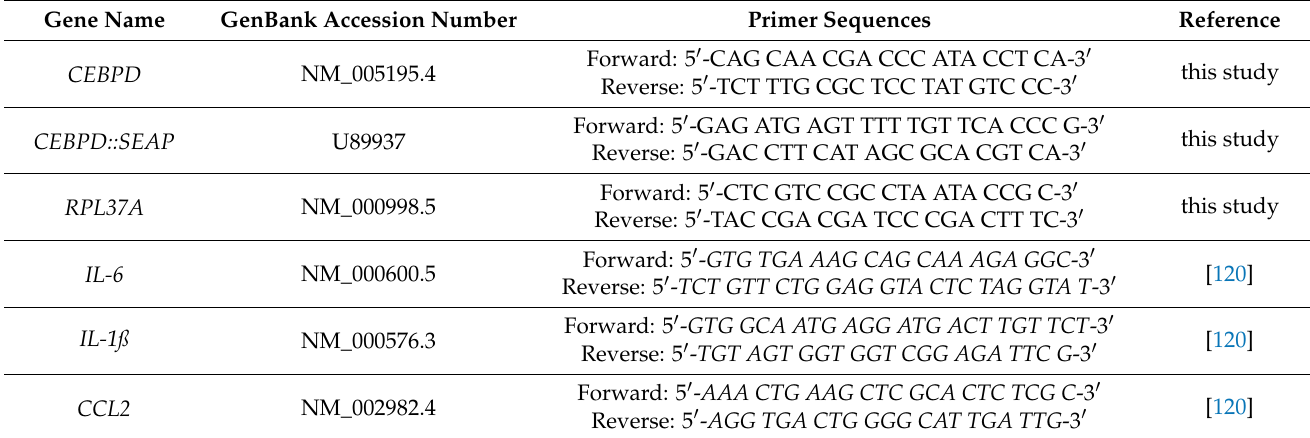
Table 5. Sequences of primers used for quantitative reverse transcriptase polymerase chain